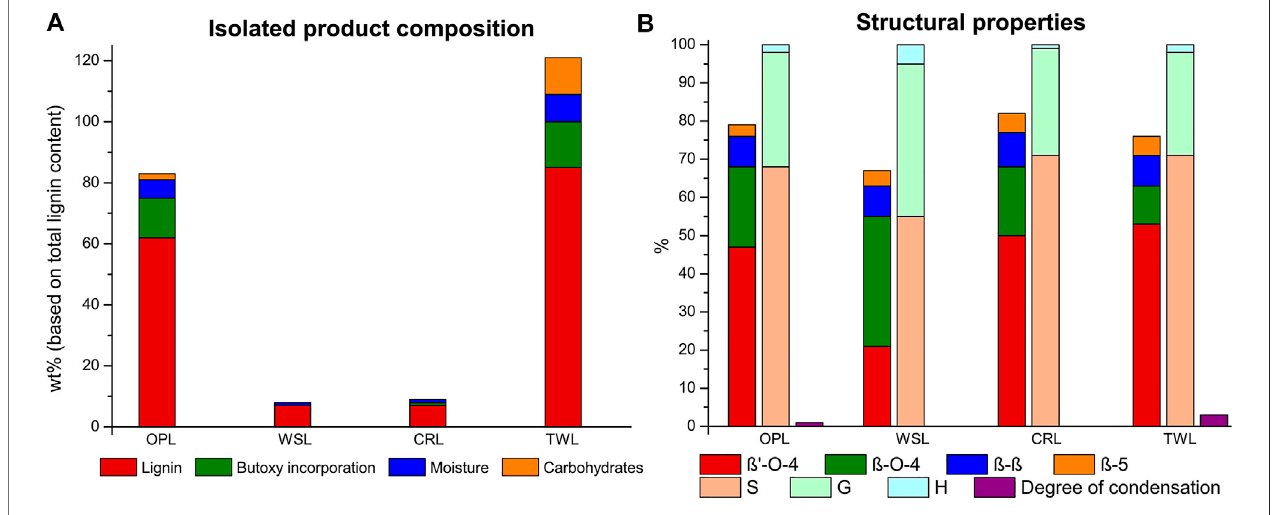
FIGURE 6 | Lignin extraction ef fi ciency with product composition with each component expressed as a percentage of the total lignin content (A) and the linkage content (per 100C9 units), S/G/H ratioand the degree of condensation (based on condensed S-units) of the isolated lignin (B) for the organic phase lignin (OPL), water- soluble lignin (WSL), and CINC residual lignin (CRL) fractions obtained after caustic soda treatment and lignin obtained via the traditional work-up (TWL).